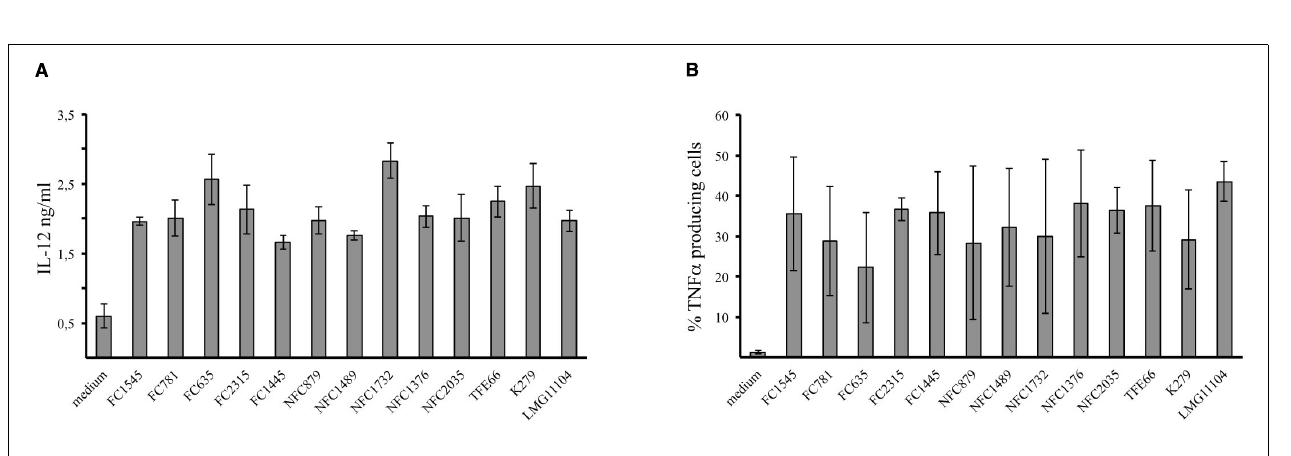
FIGURE 4 | Stenotrophomonas maltophilia strains induce cytokines production by dendritic cells. Bar graphs shown the production of IL-12 (A) and TNF a (B) by dendritic cells after incubation with the S. maltophilia strains. IL-12 and TNF a expression by DCs was measured by ELISA and